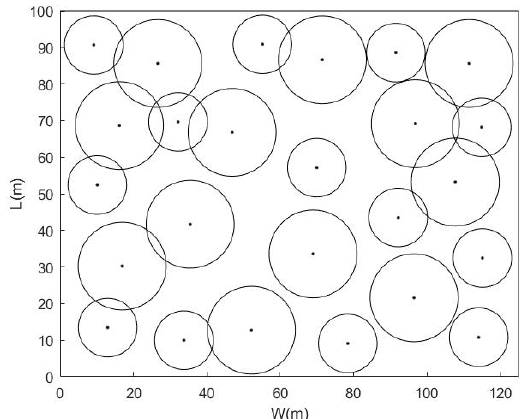
Figure 7. Randomly assigned static nodes.